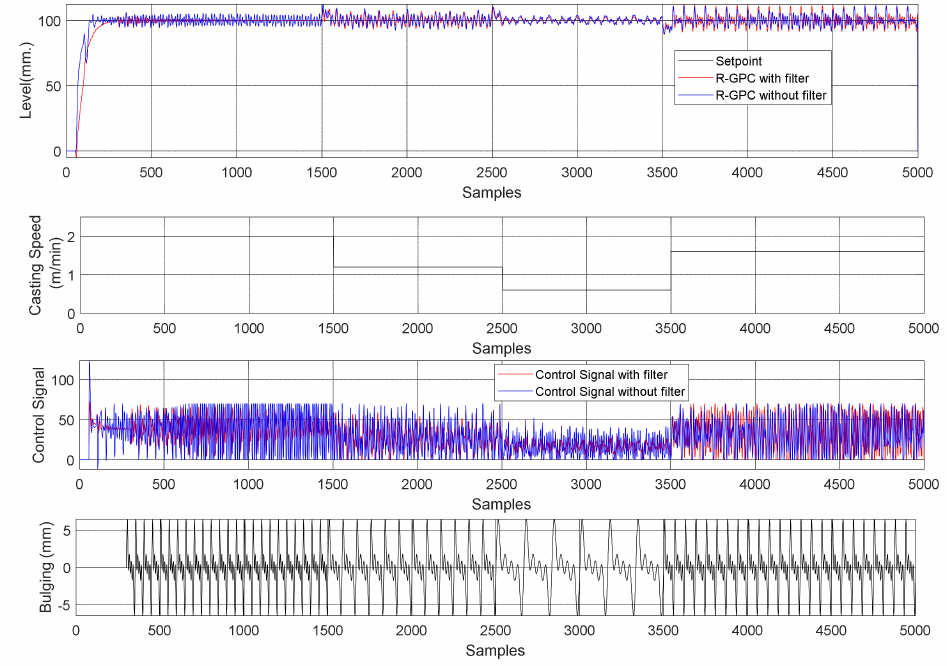
Figure 19. Process with casting speed